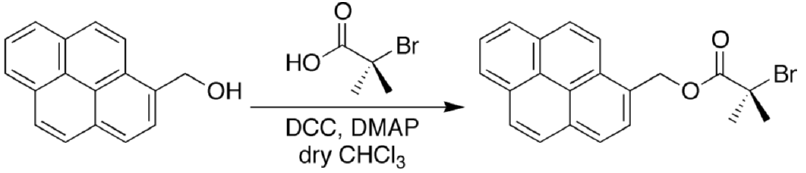
Figure 3. Synthesis of Pyr-BrB.